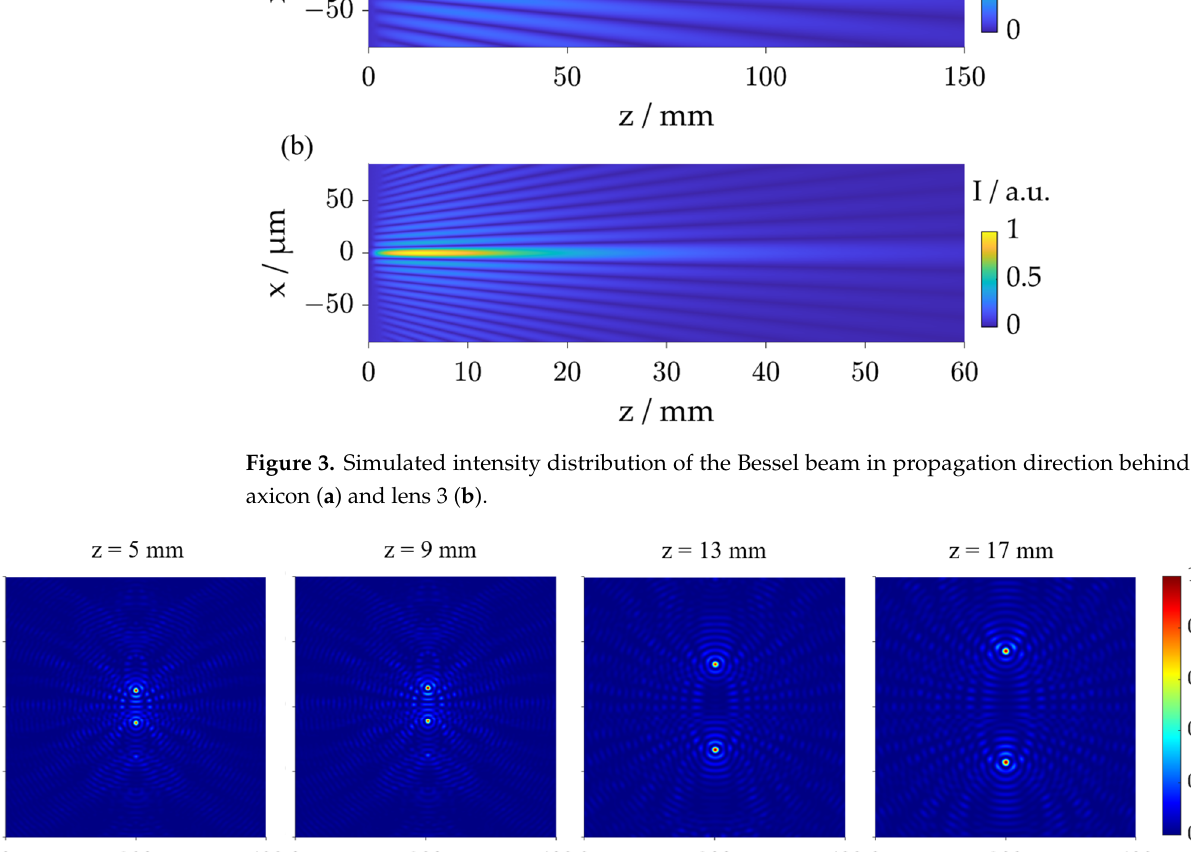
Figure 3. Simulated intensity distribution of the Bessel beam in propagation direction behind the axicon ( a ) and lens 3 ( b ).